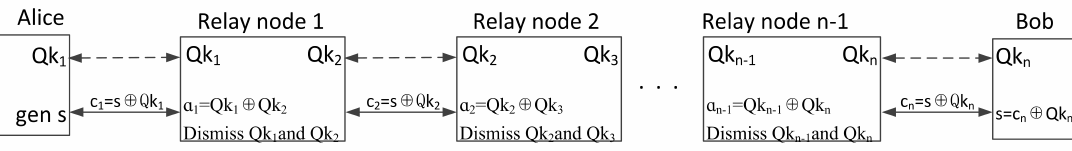
Figure 1. The model of re-encryption key distribution scheme for the relay QKD system. The dotted arrow stands for the quantum key distribution (QKD) process. The solid arrow stands for the re-encryption process. Relay node i re-encrypts the ciphertext c i and transfers c i + 1 = c i ⊕ a i to the next